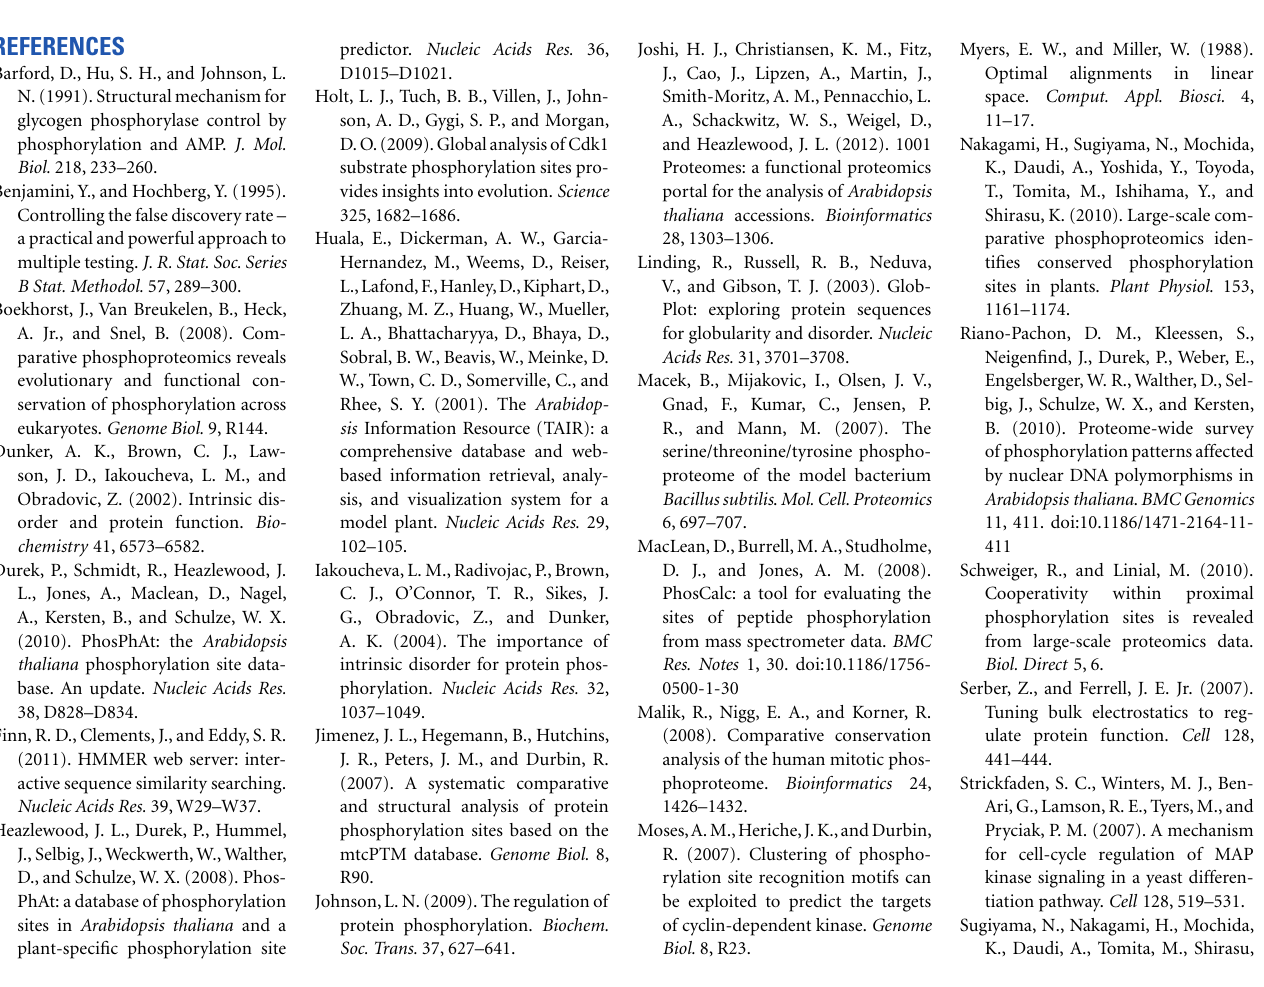
Table S1 | Predicted hotspots in the Arabidopsis proteome based SVM score > 1. (ExcelTable). File also contains data sheet of Arabidopsis P-hotspot containing proteins detected based on experimentally identified phosphorylation